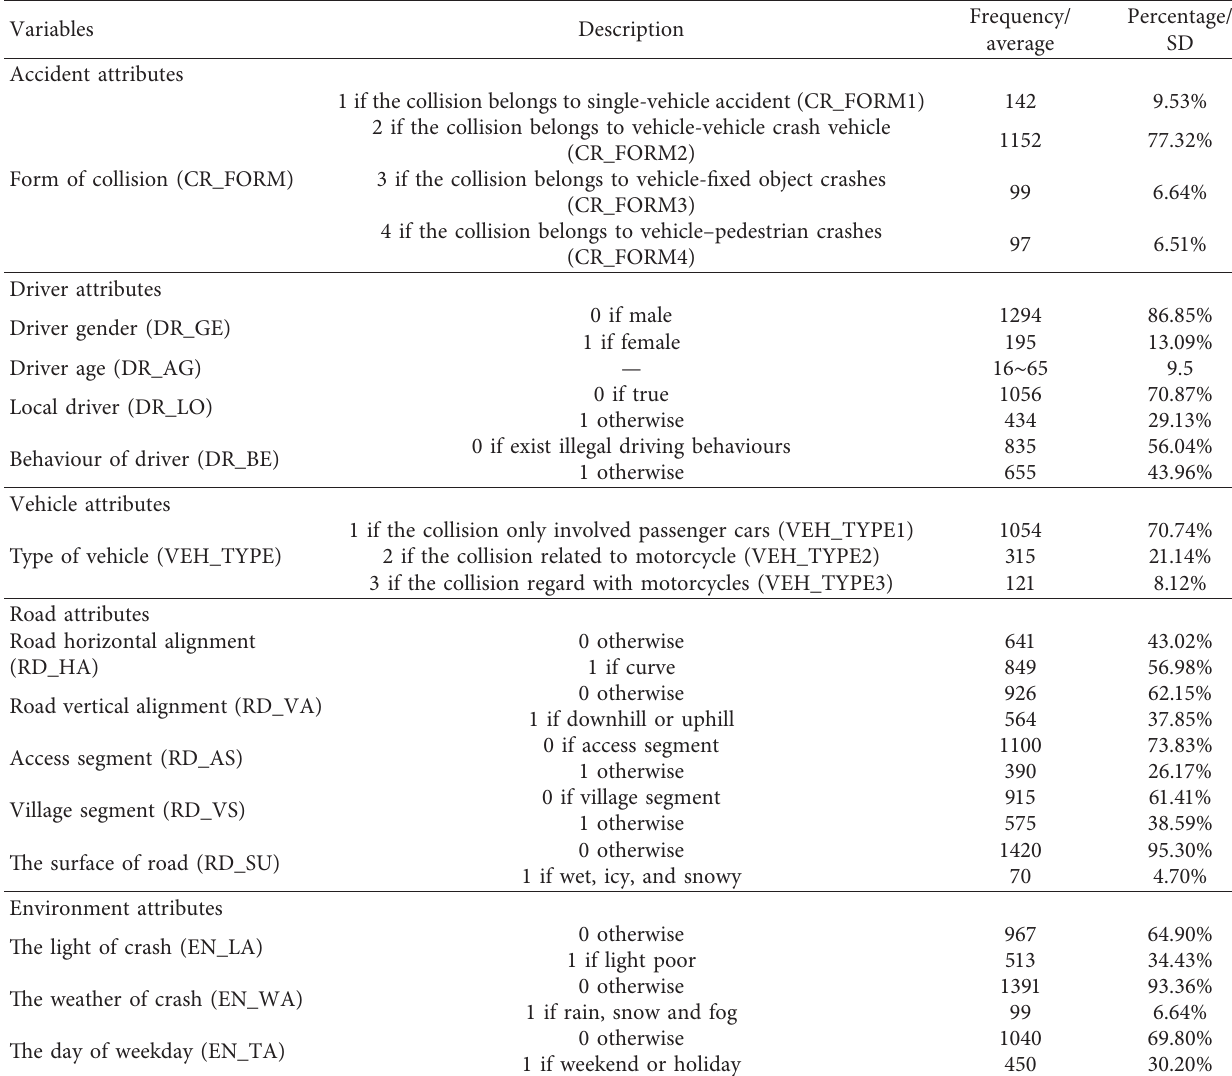
Table 2: Descriptive statistics of explanatory variables for analysing two-lane rural road crash